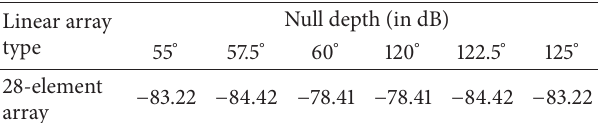
Table 4: Null depths after optimization by GWO algorithm for Example 2 .